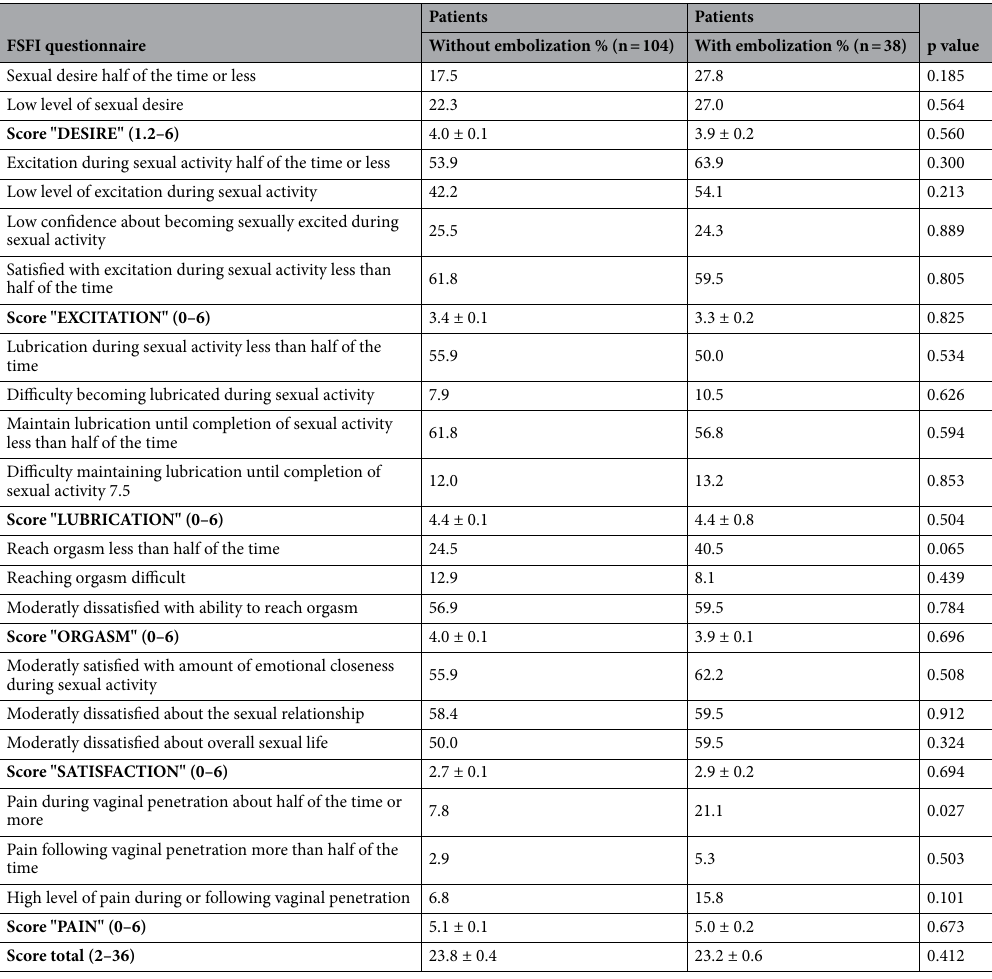
Table 3. Sexual dysfunction.